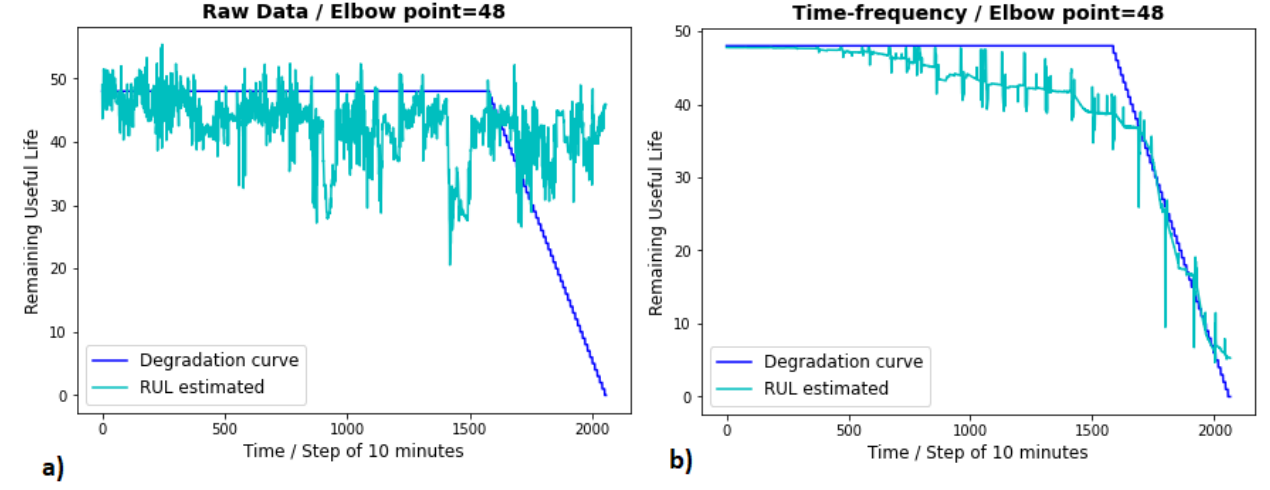
Figure 7. RUL of first CU of aircraft=enwslczm with an Elbow Point = 28: ( a ) raw data vs. ( b ) Health Indicators from time-frequency